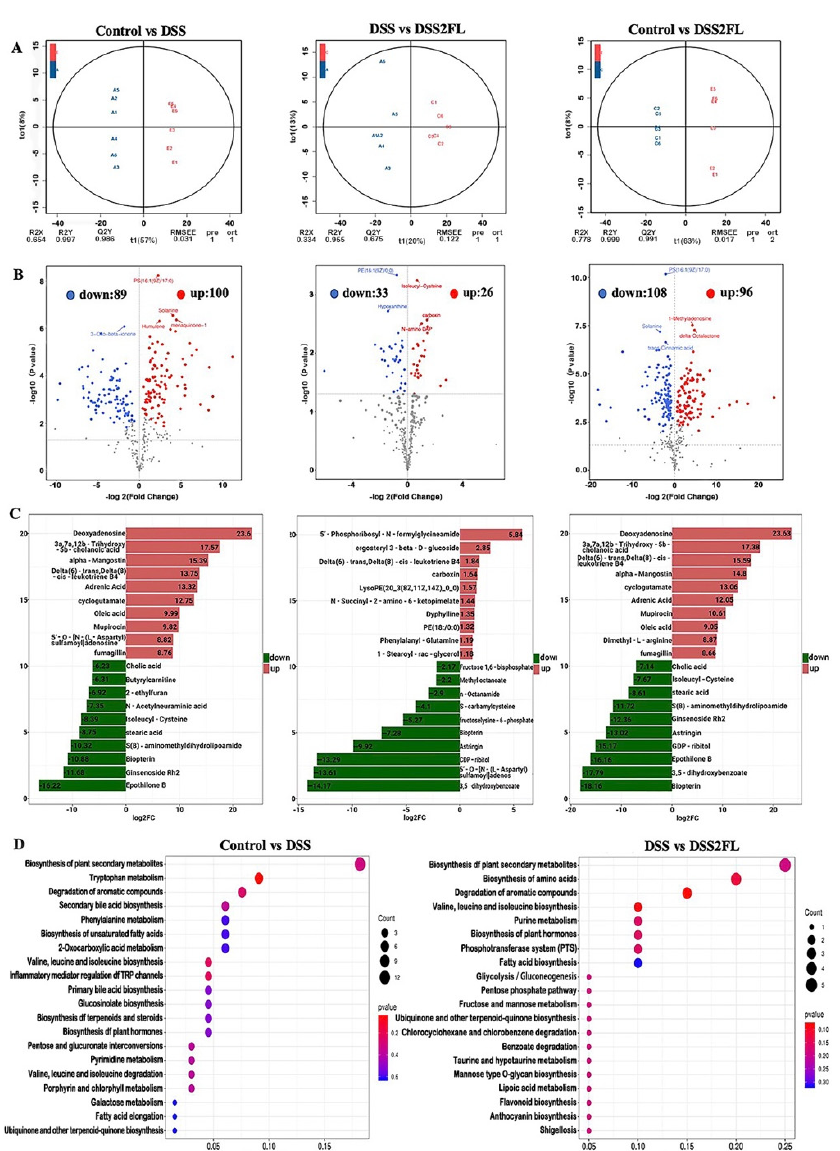
Figure 3. 2 ′ -FL-associated metabolic patterns in C57BL/6J mice. ( A ) The orthogonal projections to latent structures-discriminant analysis (OPLS-DA) among every two groups. ( B ) Volcano plot among every two groups with the criteria of fold-change (FC) threshold = 2 and p < 0.05. ( C ) The histogram of the enriched pathway of differential metabolites in B. ( D ) KEGG-enriched map of differential metabolites. In each panel, A, DSS group; C, DSS2FL group; and E, control group; n = 6 for each group.